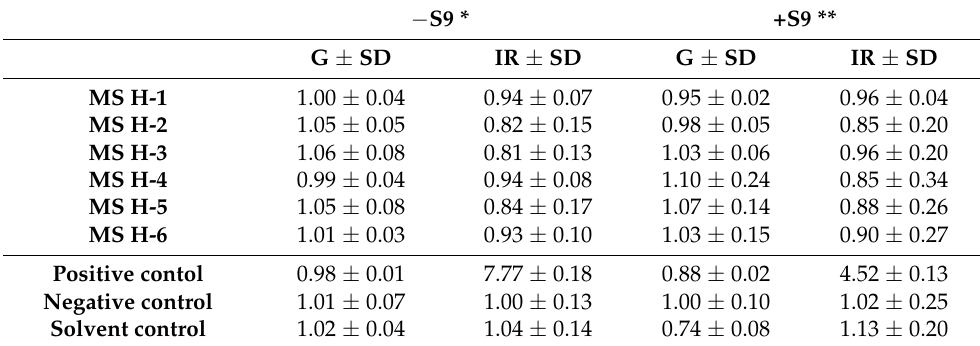
Table 4. The results of the umu-test for the extracts